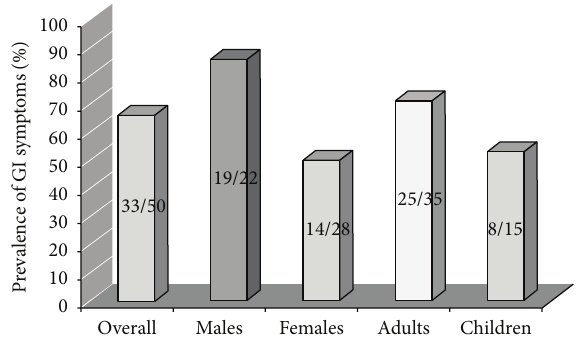
Figure 1: Prevalence of GI symptoms among 50 patients with FD.